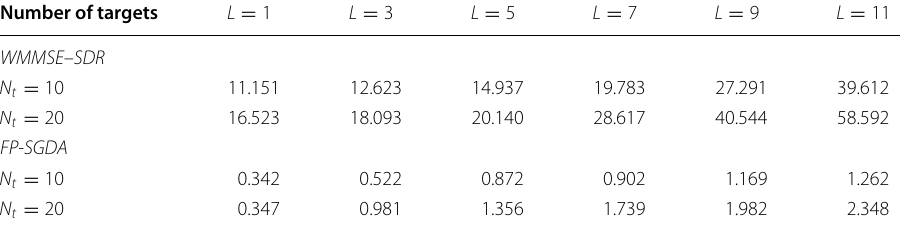
Table 1 Comparison of computational time ( s ) of WMMSE–SDR and FP‑SGDA algorithms Number of targets L =